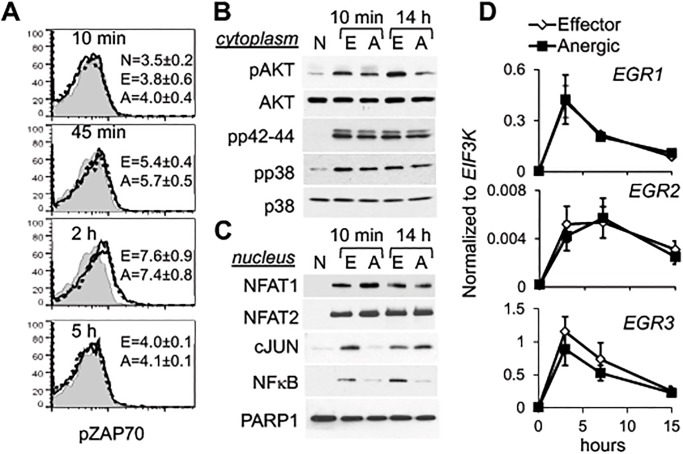
Molecular characteristics of CD4+ T cells activated in the presence of co-stimulatory inhibition.Naïve CD4+ T cells were activated as in Fig 1B. A. Phosphorylation of ZAP70 in CD4+ T cells stimulated for the indicated time periods was analyzed by FACS. Shown is one representative experiment with the mean of fluorescence intensity for each population ± SEM from 5 independent experiments. Gray plot is naïve cells (N, unstimulated); dotted line is effector cells (E, αCD3 + αCD28); solid line is anergic cells (A, αCD3 + CTLA4-Ig). B. Activation of AKT and MAPKs in cytoplasm and C. translocation of transcription factors to the nucleus during activation were examined by western blot (cytoplasmic AKT and p38 and nuclear PARP1 were used as loading controls). Each experiment was repeated at least 3 times. D. mRNA expression of indicated genes was measured by real-time PCR (n = 5). Data are presented as mean ± SEM.